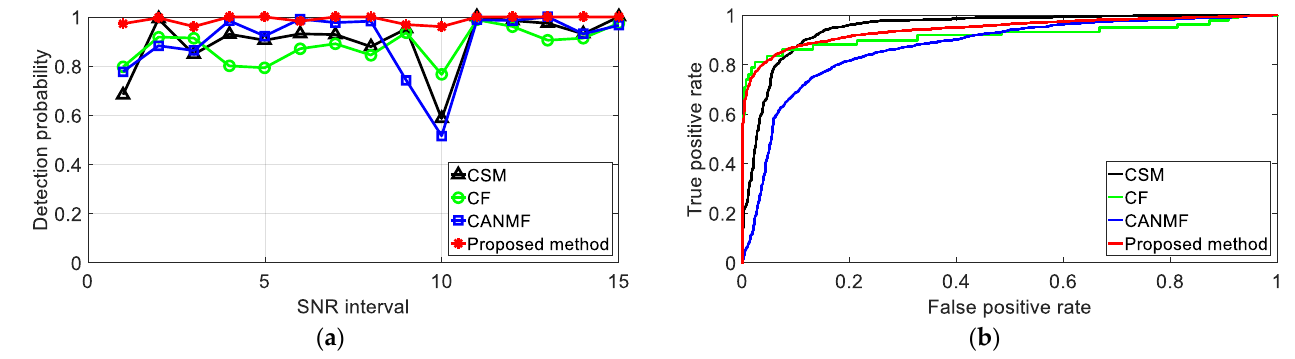
Figure 15. Target detection probability (observation time 2.048 s). ( a ) Detection rates of different algorithms. ( b ) ROC curves of different algorithms.